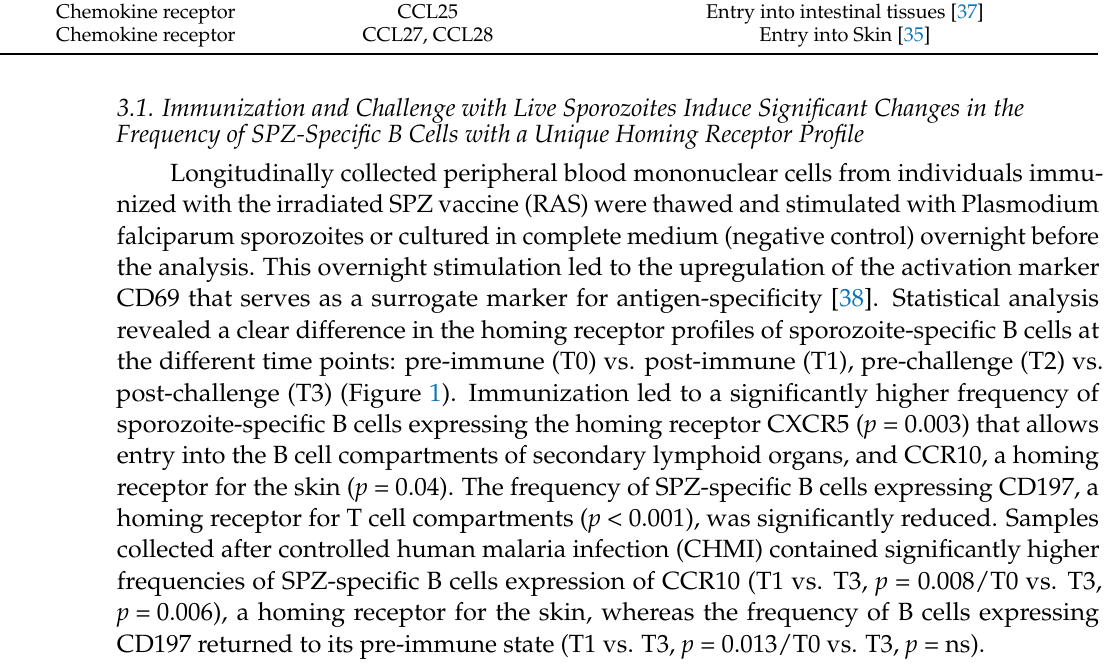
Figure 2. Homing receptor profile of SPZ-specific CD4 + T cells at different time points after vaccina- tion and CHMI. Statistical analysis revealed that the frequency of CD69 + CD4 + T cells expressing the skin-specific marker CCR10 (left panel), CD196 (middle panel), and liver-specific CD186 (right panel) was significantly altered when testing samples obtained at q different time points (T0 = pre- immune, T1 = 2 weeks after the third immunization, T2 = 5–6 days after CHMI, T3 = 3–4 months after CHMI). Asterisk indicates statistical significance (* p < 0.05). 3.3. RAS Vaccine and Live SPZ Challenge Induce a Complex Profile of Homing Receptors on SPZ-Specific CD8 + T Cells Defining the homing receptor profile of longitudinally collected peripheral blood, SPZ-specific CD8 + T cells revealed upregulation of a variety of homing receptors resulting